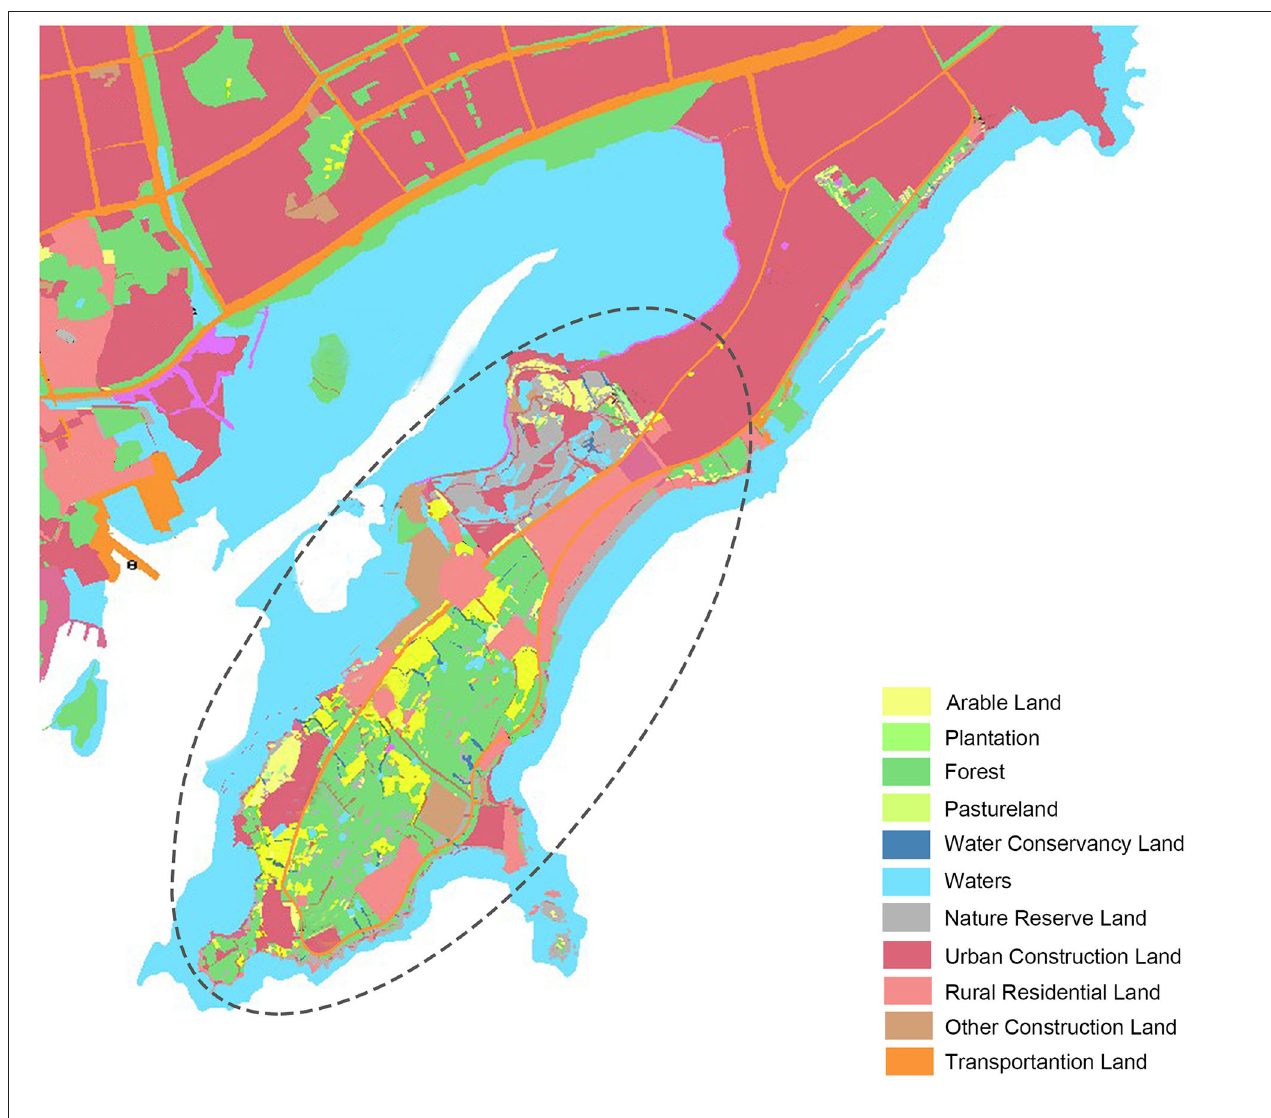
FIGURE 11 | Master planning of land use